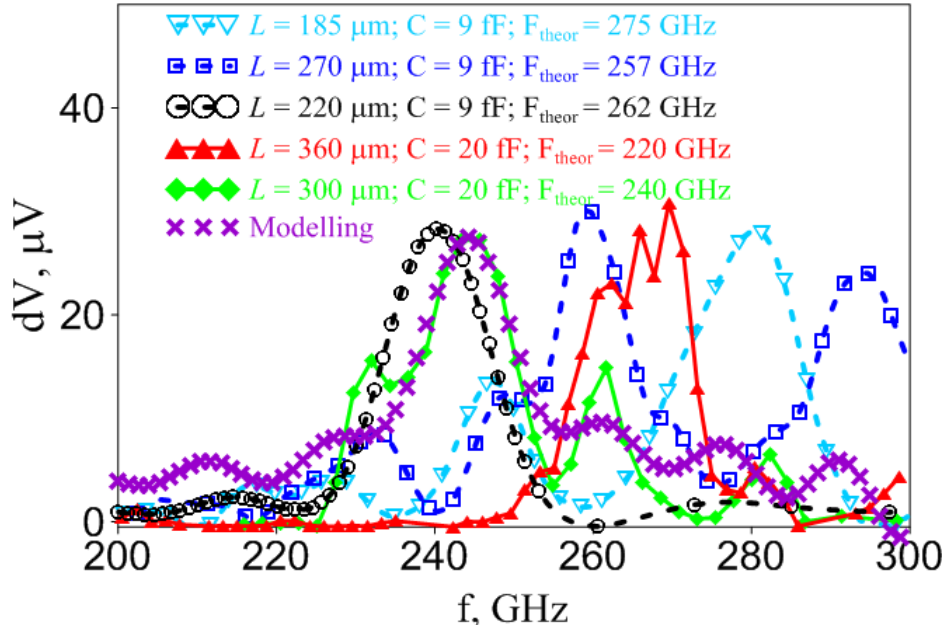
Figure 4. The amplitude-frequency characteristics of cold-electron bolometers with different capac- itance C and lengths L of coplanar lines. Solid curves — rectangular coplanars, dashed curves — rounded coplanars, crosses — theory for the parameters close to the experiment for green solid curve with diamonds.